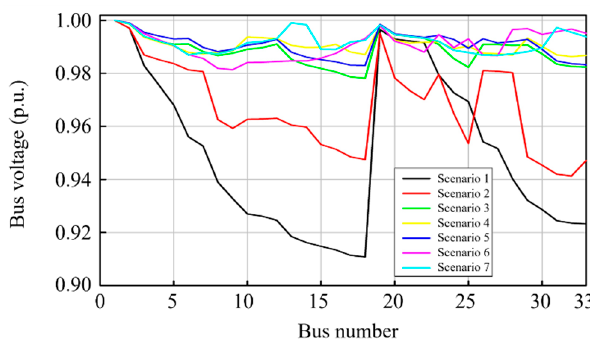
Figure 3. A comparison of bus voltage profile of 33-bus system for seven scenarios performed by proposed ASFLA.